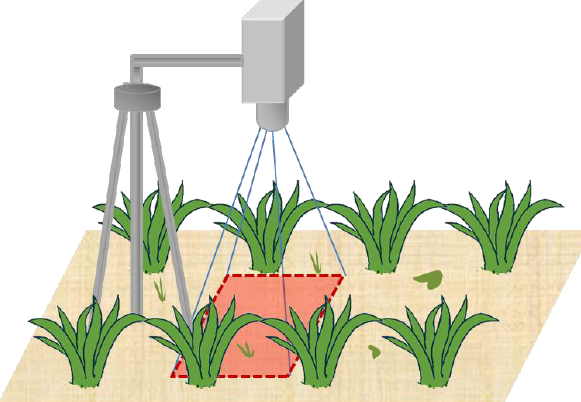
Figure 6. Acquisition process: camera on a tripod at approximately 1.5 m height pointing vertically